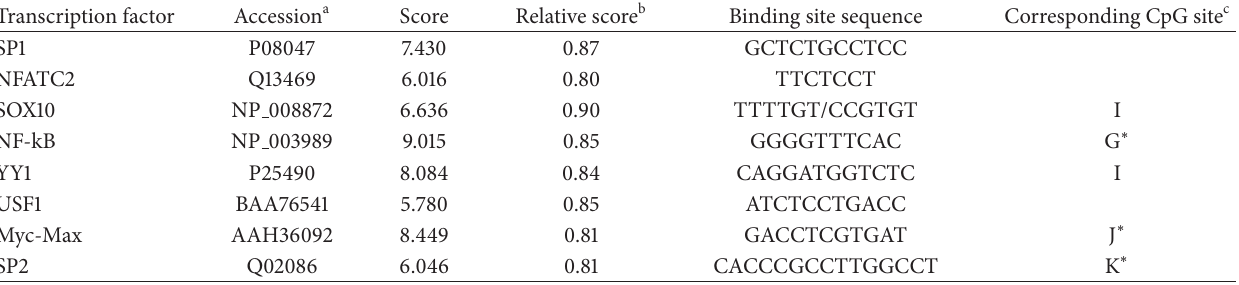
Table 4: Possible transcription factor binding sites identified by